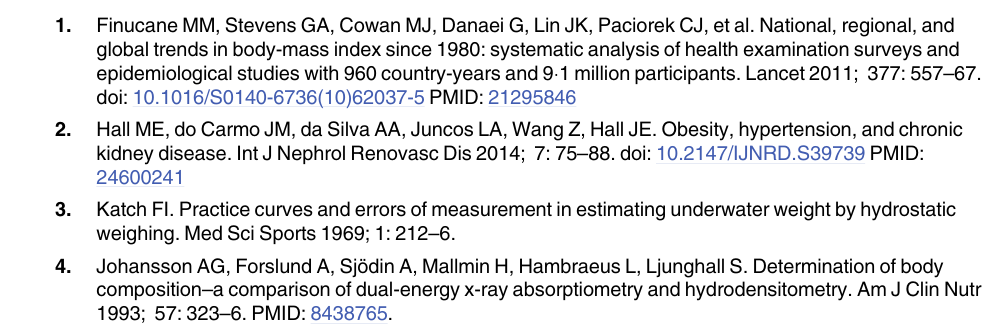
Fig 4. Scatter and regression plots of BF% DXA according to FFM BIA8 and FFM DXA differences. (a) total subjects ( n = 711), (b) male subjects ( n = 412), and (c) female subjects ( n = 299). The bold line represents the regression